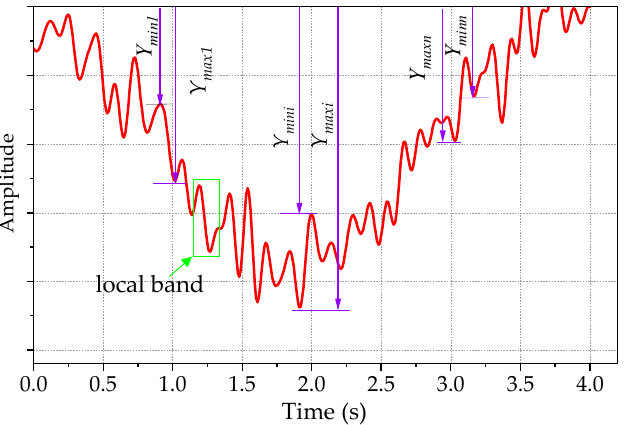
Figure 4. Principle of the WAM.